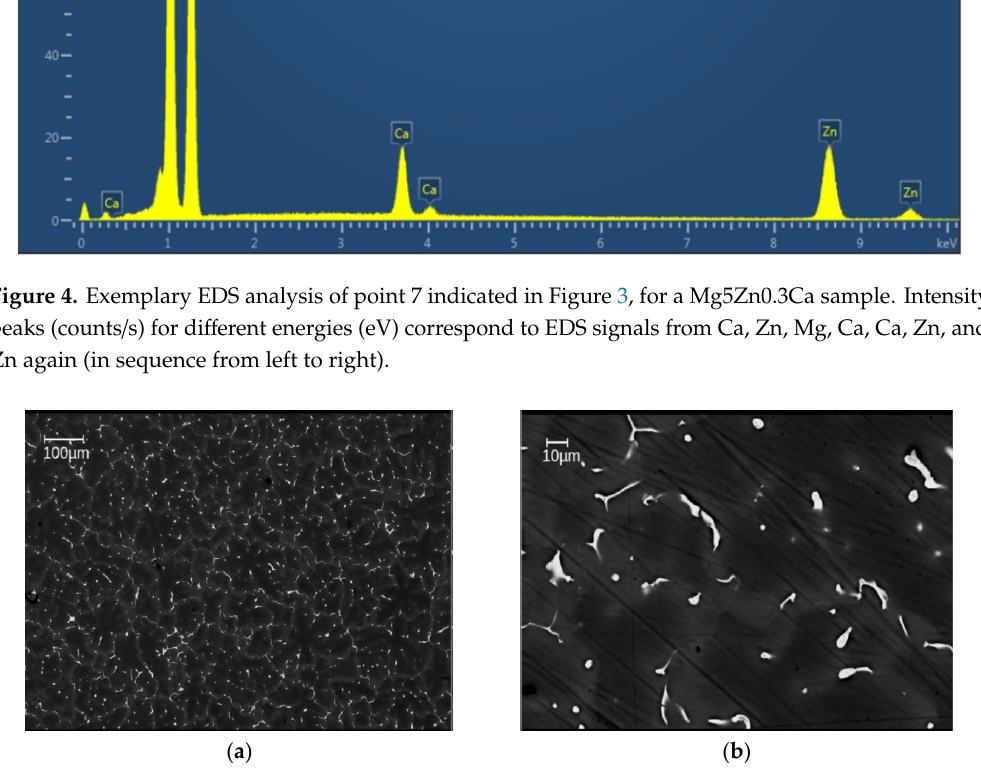
Figure 6. SEM images of all alloys after best ‐ condition annealing, and quenching or furnace ‐ cooling. The results of microhardness (HV0.05) measurements of as ‐ cast Mg5Zn0.3Ca, Mg5Zn, Mg0.3Ca, Mg5Zn0.15Ca and Mg5Zn0.15Ca0.15Zr samples, and in their furnace ‐ cooled or quenched states, are listed in Table 3.